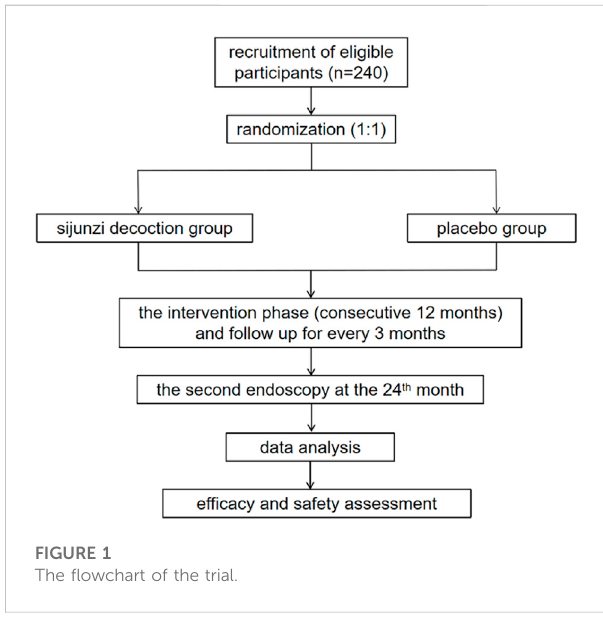
FIGURE 1 The fl owchart of the